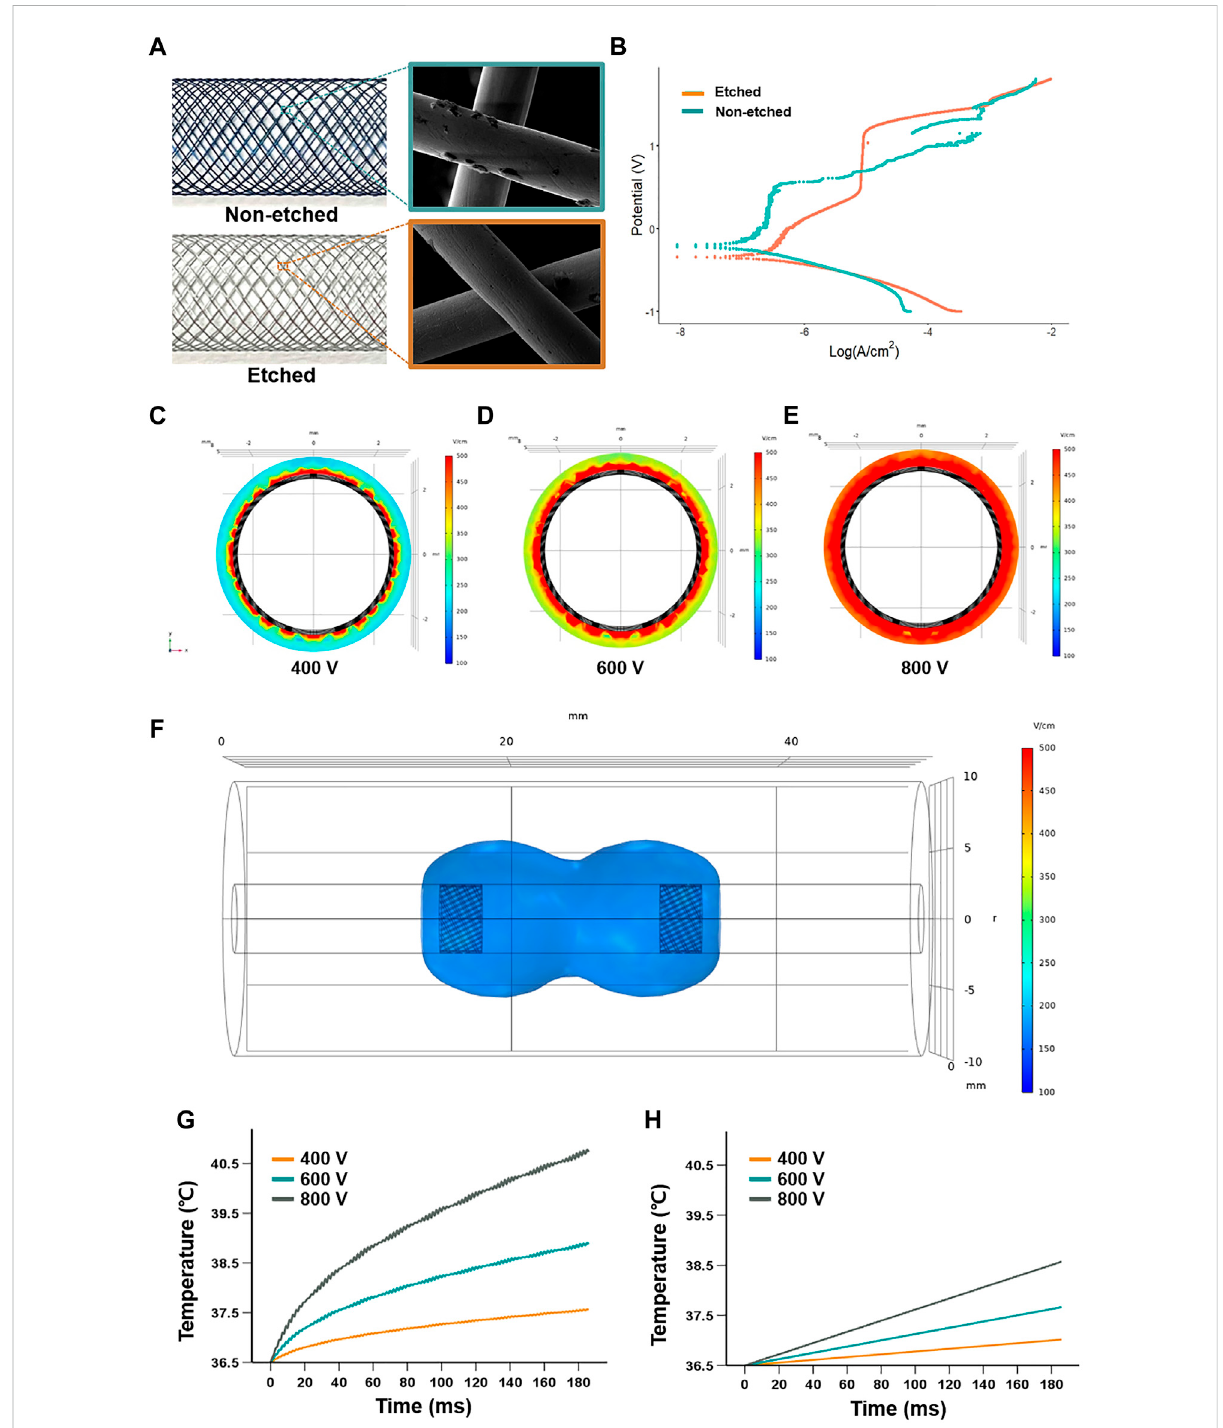
FIGURE 2 Characteristics and stimulation of the self-expandable electrode (SE). (A) SEM analysis of the surface characteristics of the nitinol wires before andaftertheplasmaetching. (B) Anodicpolarizationcurvesoftheelectricalpropertiesoftheetchedelectrode,using0.9%sodiumchloridesolution. The electric fi eld distribution of axial-sectional views at the middle of the cathode when applied (C) 400 V, (D) 600 V, and (E) 800 V show a depth penetration of 0.204 mm, 0.315 mm, and 0.374 mm in a simulated esophageal model, respectively. (F) Representative iso-surface of the electric fi eld at 400 V was applied. Graphs show that temperature changes over time at (G) the SE and (H) the middle portion between the two SEs when applied 400, 600, and 800